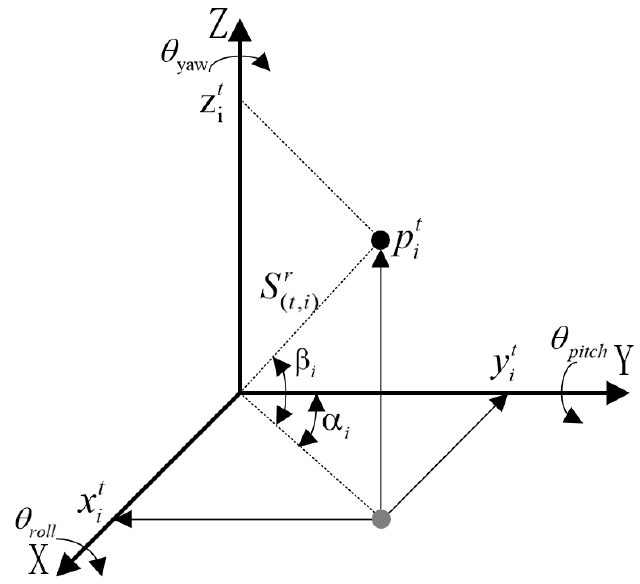
Figure 4. Point cloud reprojection.